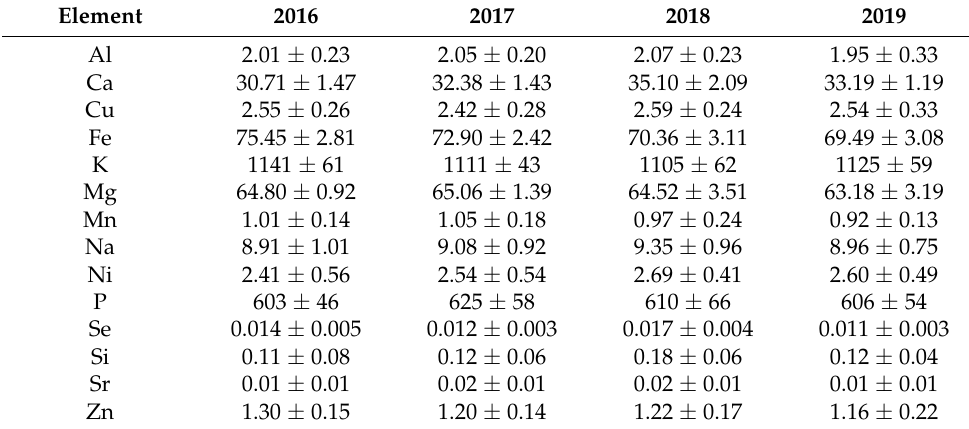
* mean values of data obtained from 5 independent samples from the 5 AHP trees, and the standard deviation ( s 5 ) of the average. Table 9. Concentrations of some elements (mg/100 g, on flour dry matter basis) * in horse chestnut TISS fraction from AHH semen, harvested in different years.